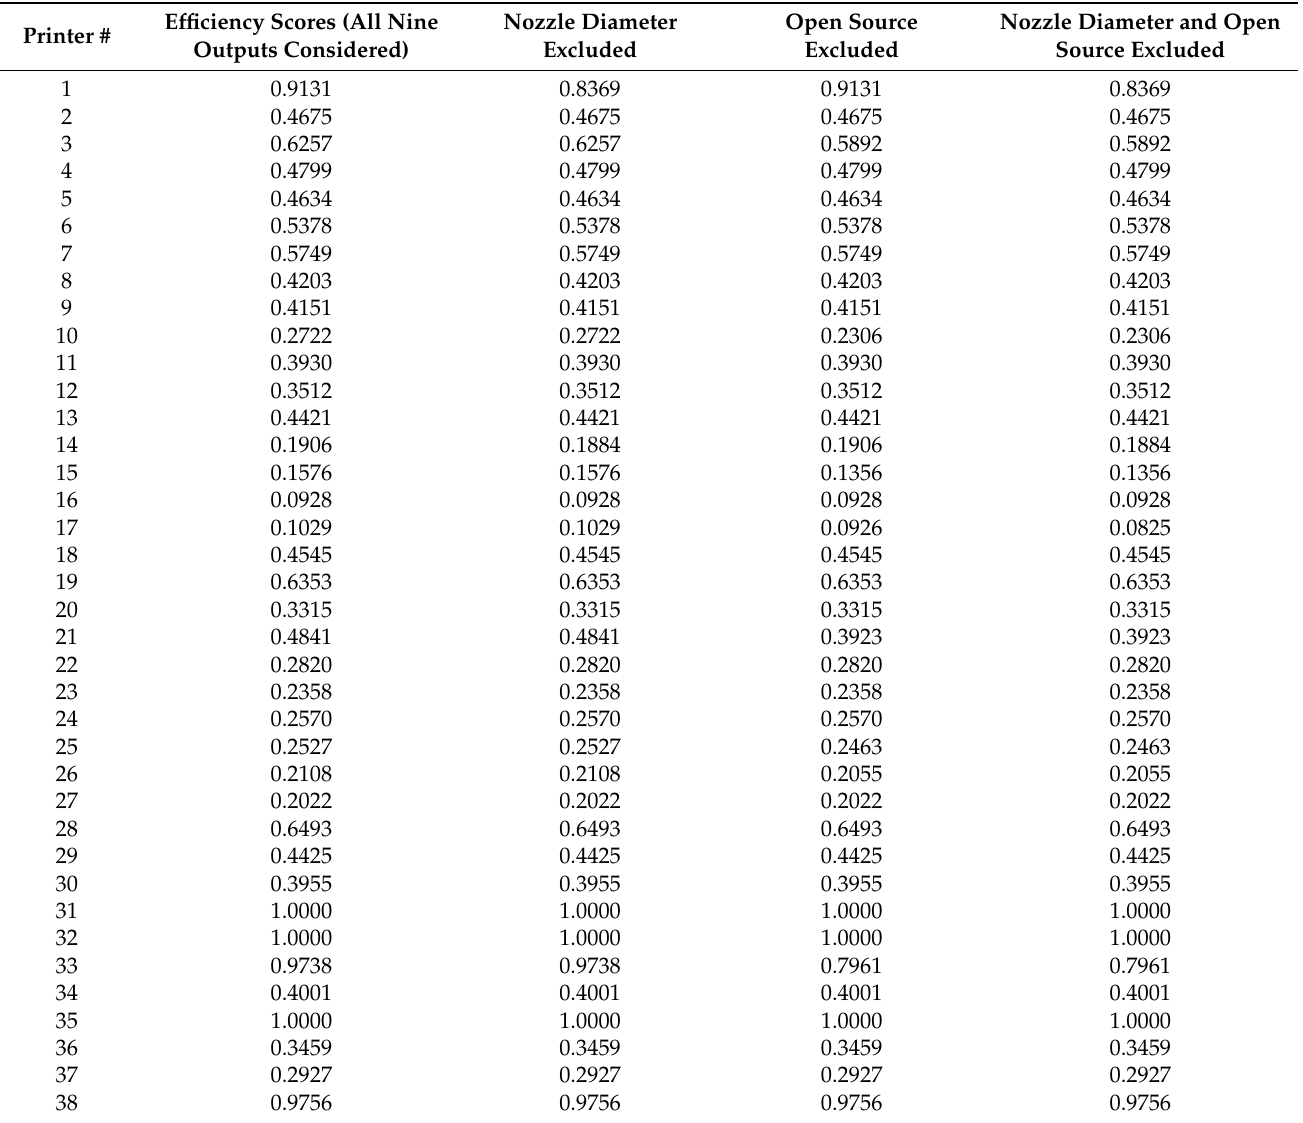
Table 8. Efficiency scores for the extended sample of 38 printers, for different combinations of output